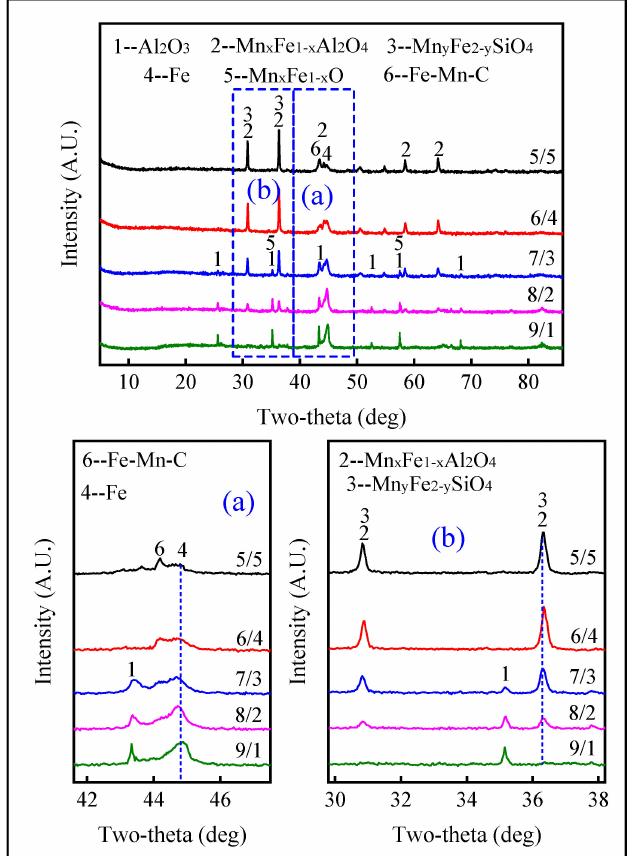
Figure 9. XRD patterns of the reduced briquettes at 1300 ◦ C for 2 h under FC/O of 1.0 with the different proportions of Fe-Al ores/Fe-Mn ores, ( a ) is the XRD pattern of 2 θ =41.7 ~ 2 θ =47.5 and ( b ) is the XRD pattern of 2 θ =29.8 ~ 2 θ